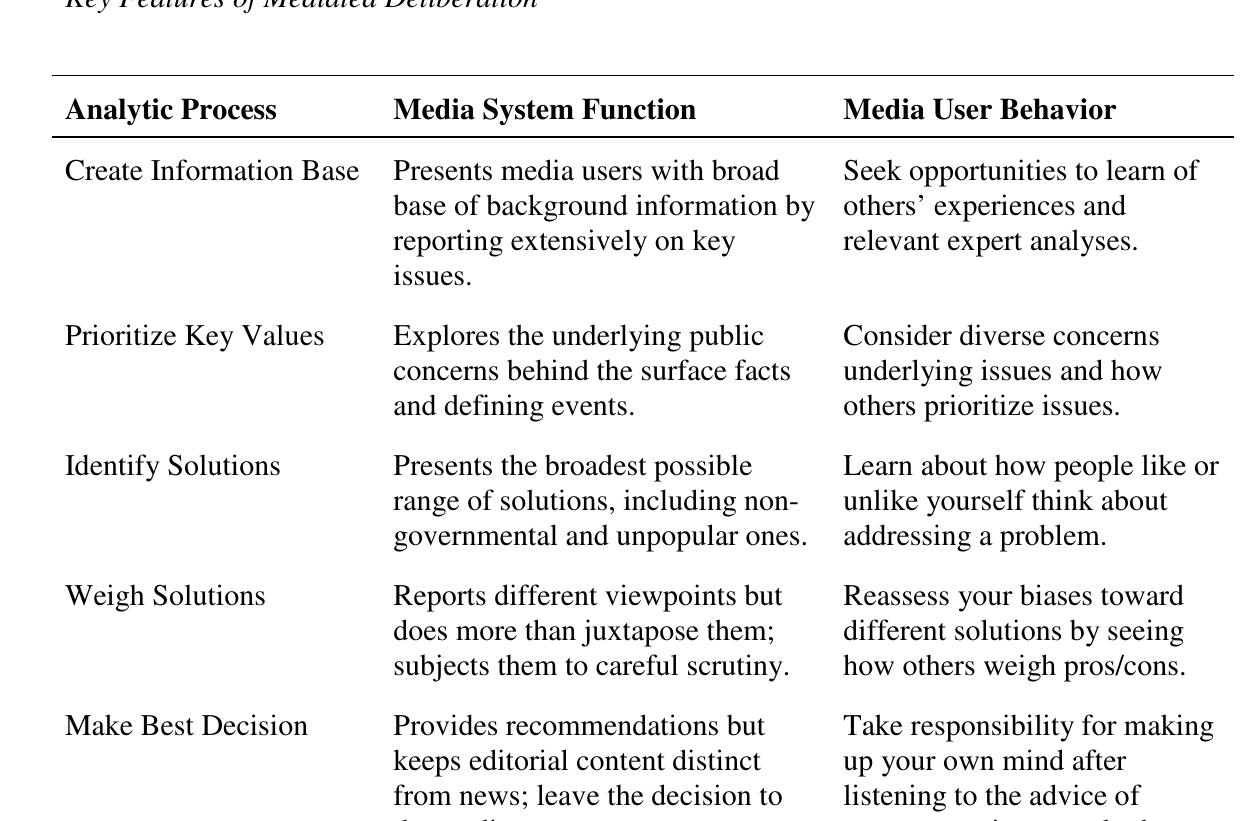
Table 2 Key Features of Mediated Deliberation